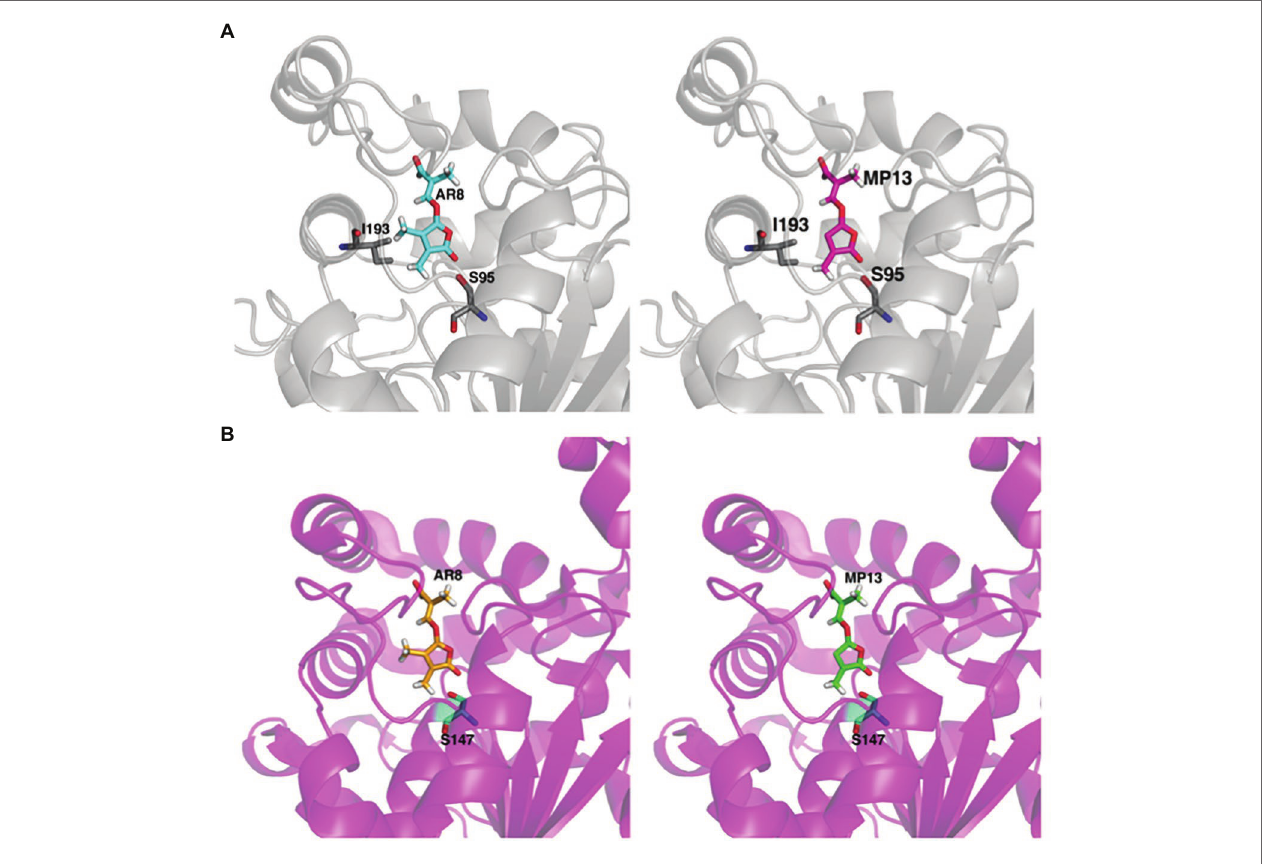
FIGURE 7 | In silico structural analysis of MP13 and AR8 binding toward ShHTL7 and OsD14. (A) Cartoon representation of ShHTL7 (pdb: 5Z8P, gray) bound to AR8 (blue stick) and MP13 (magenta stick) and (B) OsD14 (pdb: 5dj5, magenta) bound to AR8 (Orange stick) and MP13 (green